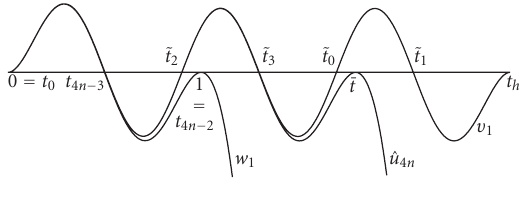
Figure 3.2. Proof of Lemma 3.4 for n =